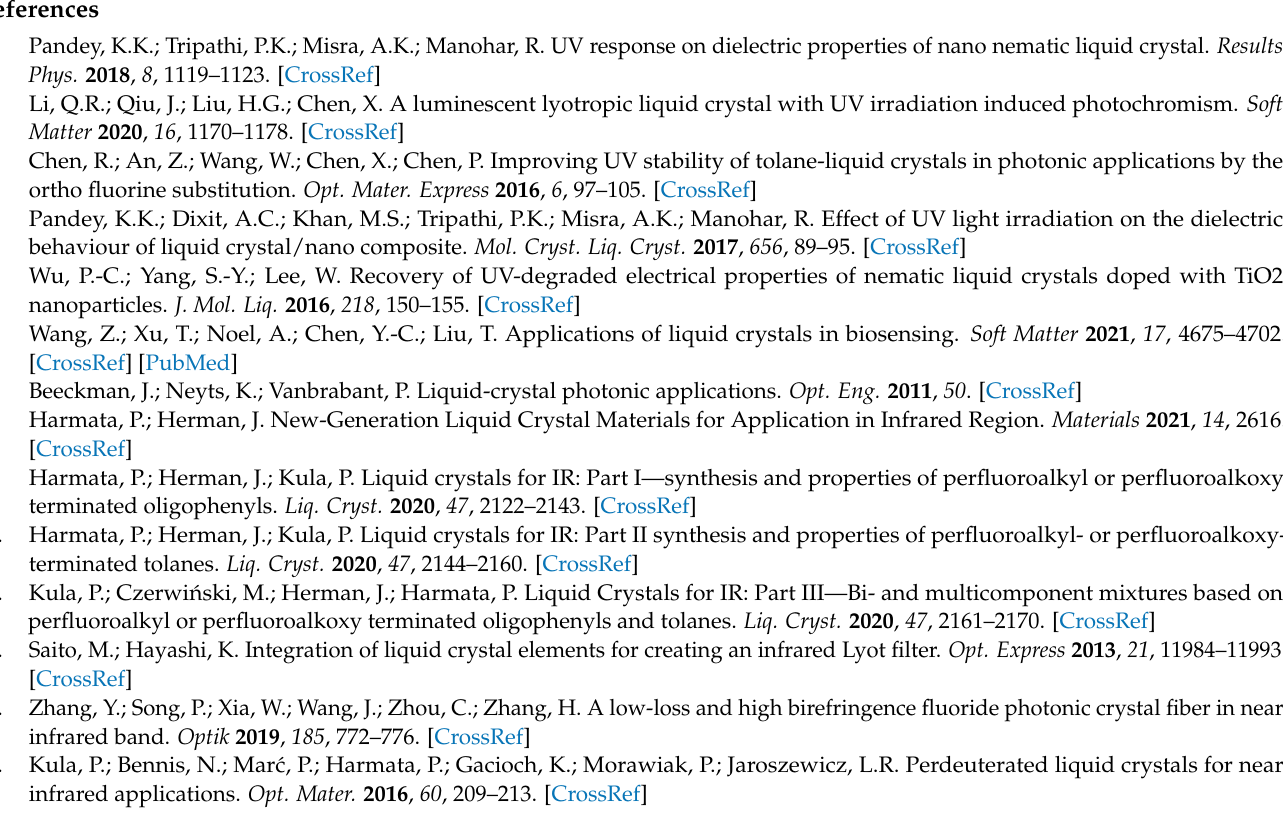
trum of compound 23_D , Figure S23. IR spectrum of compound 25_H , Figure S24. IR spectrum of compound 25_D , Figure S25. IR spectrum of compound 32_H , Figure S26. IR spectrum of compound 32_D , Figure S27. IR spectrum of compound 35_H , Figure S28. IR spectrum of compound 35_D , Figure S29. 1 H NMR spectrum of compound 22_D , Figure S30. 1 H NMR spectrum of compound 23_D , Figure S31. 1 H NMR spectrum of compound 32_D , Figure S32. 1 H NMR spectrum of com- pound 33_D , Figure S33. 1 H NMR spectrum of compound 35_D , Figure S34. POM texture of nematic phase of compound 33_D , Figure S35. POM texture of nematic phase of compound 33_D , Figure S36. POM texture of nematic phase of compound 25_D , Figure S37. POM texture of nematic phase of compound 35_D , Table S1. Measured refractive indices (n e and n o ) of 33_D at λ = 443, 636, and 1550 nm, and at different temperatures, Table S2. Measured refractive indices (n e and n o ) of 33_H at λ = 443, 636, and 1550 nm, and at different temperatures, Table S3. Measured refractive indices (n e and n o ) of 23_D at λ = 443, 636, and 1550 nm, and at different temperatures, Table S4. Measured refractive indices (n e and n o ) of 23_H at λ =443, 636, and 1550 nm, and at different temperatures, Table S5. Measured refractive indices (n e and n o ) of 25_D at λ = 443, 636, and 1550 nm, and at different temperatures, Table S6. Measured refractive indices (n e and n o ) of 25_H at λ = 443, 636, and 1550 nm, and at different